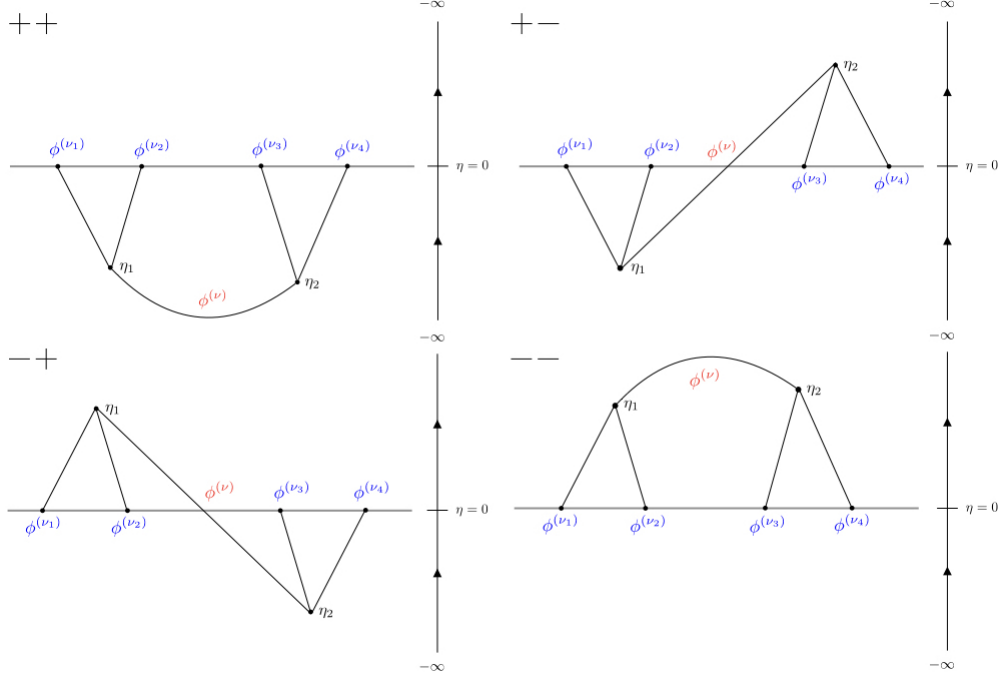
Figure 7. Tree exchange diagrams of a general scalar (cid:30) ( (cid:23) ) contributing to the correlation function h (cid:30) ( (cid:23) 1 ) (cid:30) ( (cid:23) 2 ) (cid:30) ( (cid:23) 3 ) (cid:30) ( (cid:23) 4 ) i at late times (cid:17) 0 (cid:24) 0. The + (cid:0) and (cid:0) + contributions (top right and bottom left) factorise into a product of two late-time three-point contact diagrams, one from the + branch of the in-in contour and the other from the (cid:0)